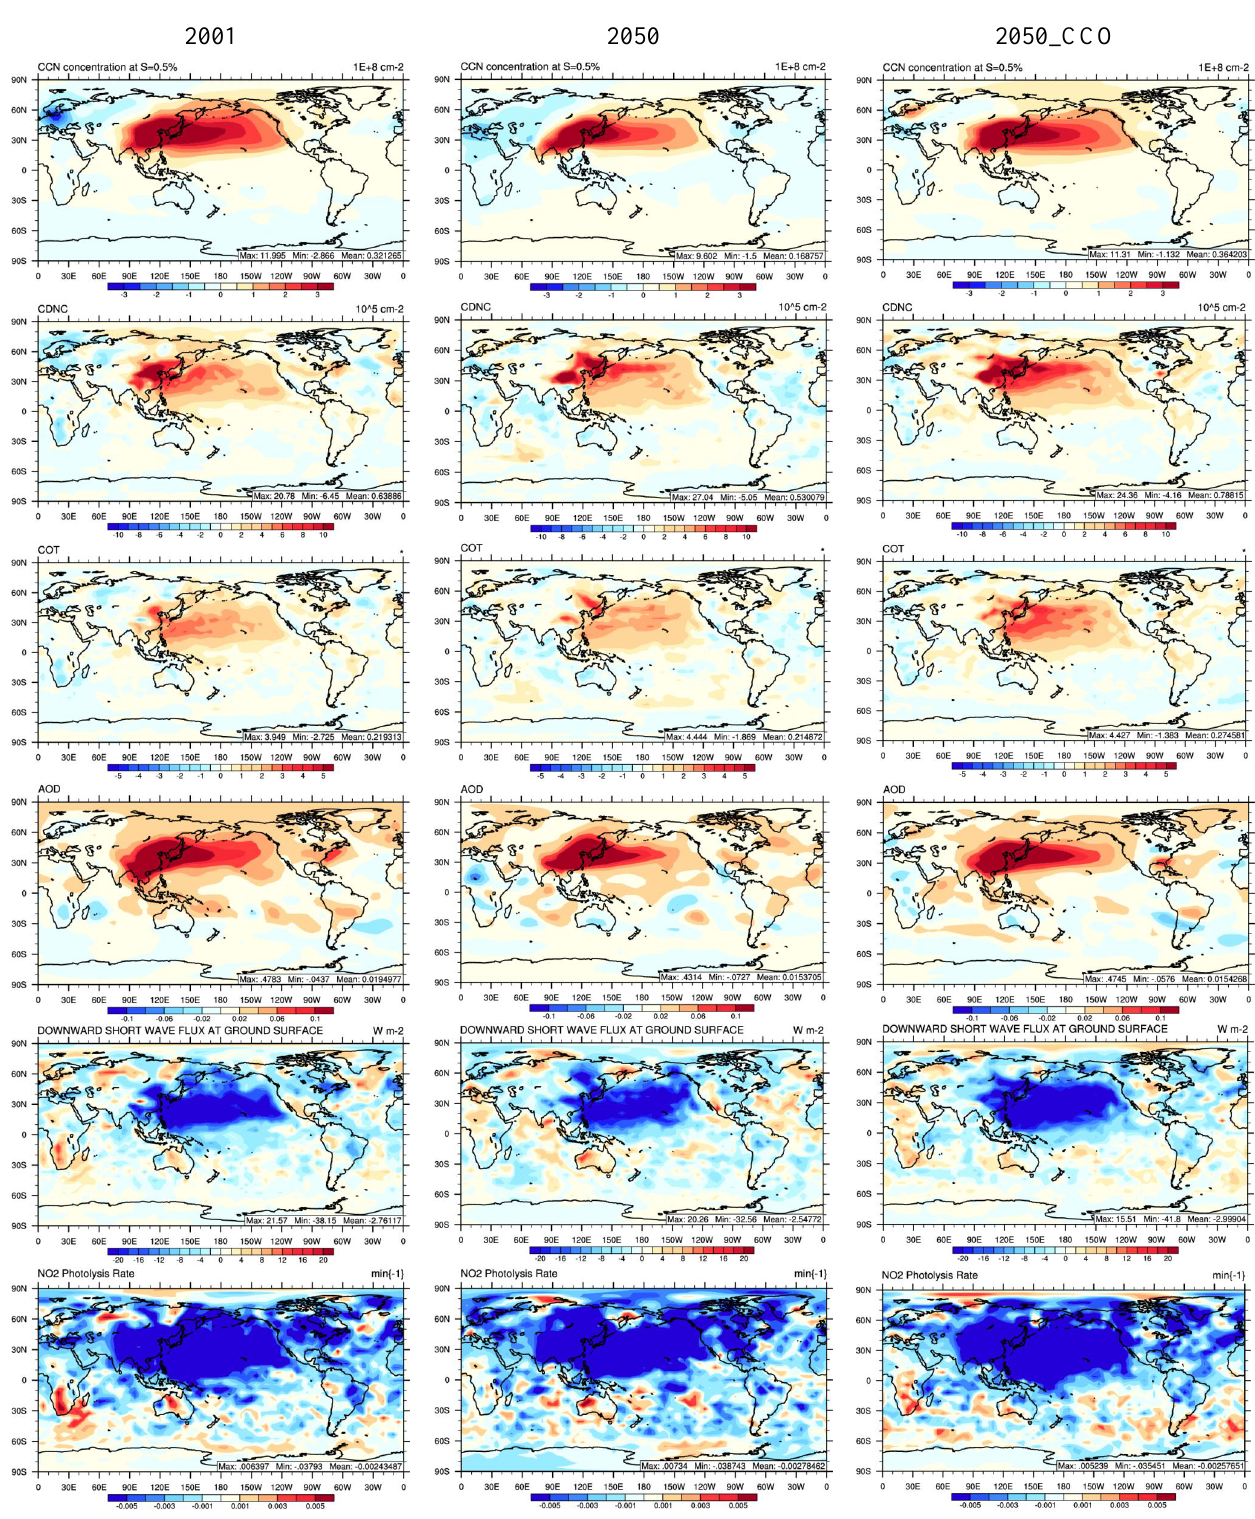
Figure 9. The difference in the spring (MAM) average cloud condensation nuclei (CCN), cloud droplet number concentration (CDNC), cloud optical thickness (COT), aerosol optical depth (AOD), downward solar radiation flux (ISR), and the photolysis rate of NO 2 (JNO 2 ) between the simulations with and without EAAEs for the current (2001), future (2050), and climate change only (2050_CCO) scenarios.